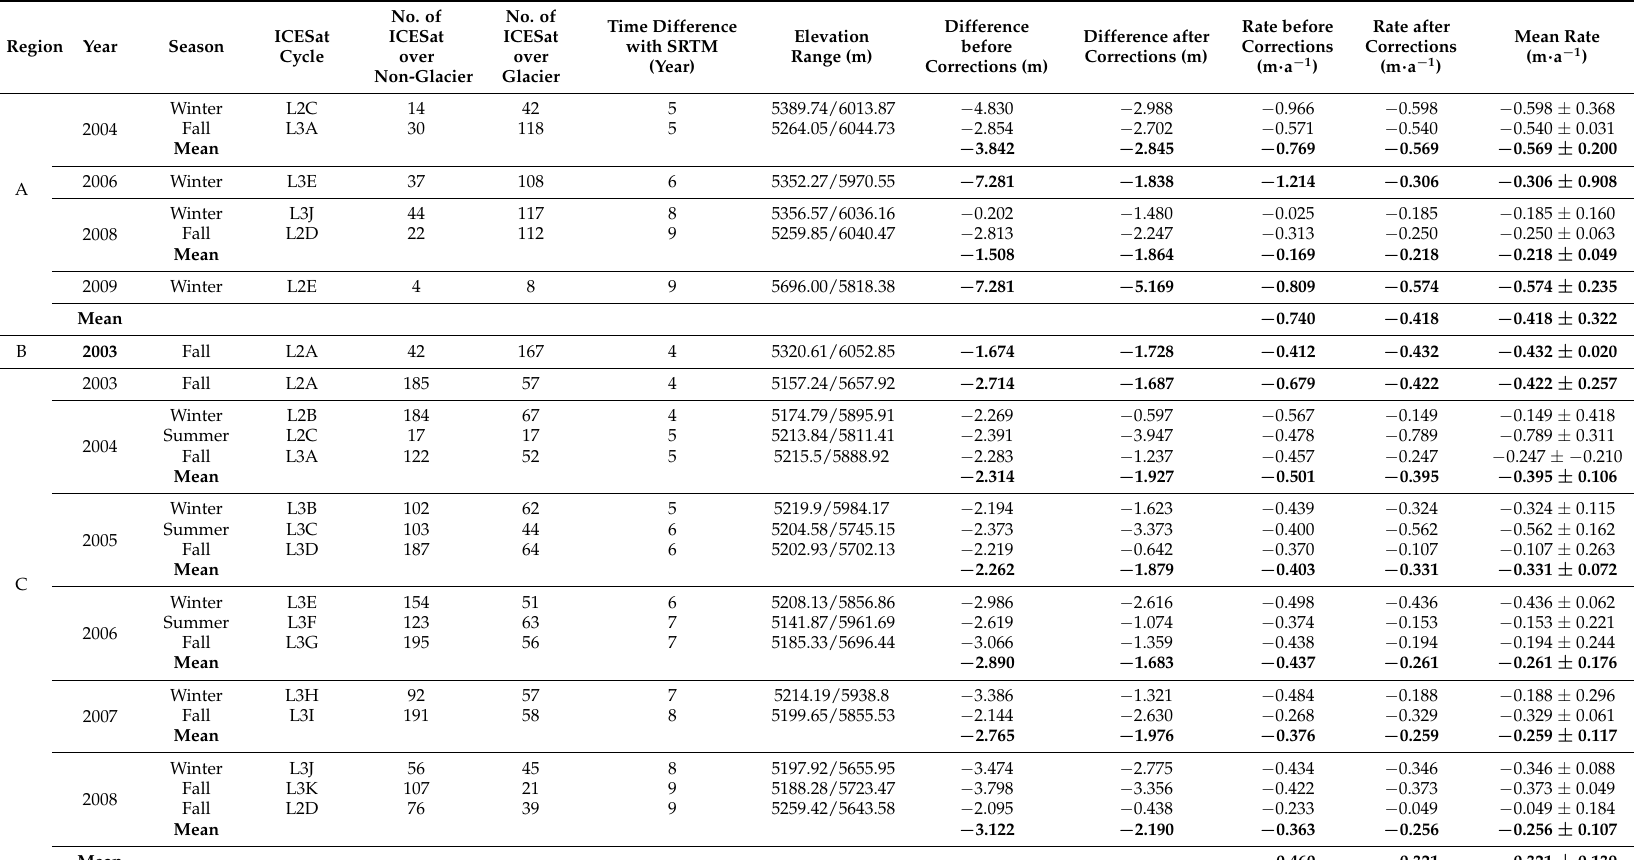
Table 2. Statistics of differences between ICESat and SRTM-derived heights and rates in Regions A, B, and C from Equation